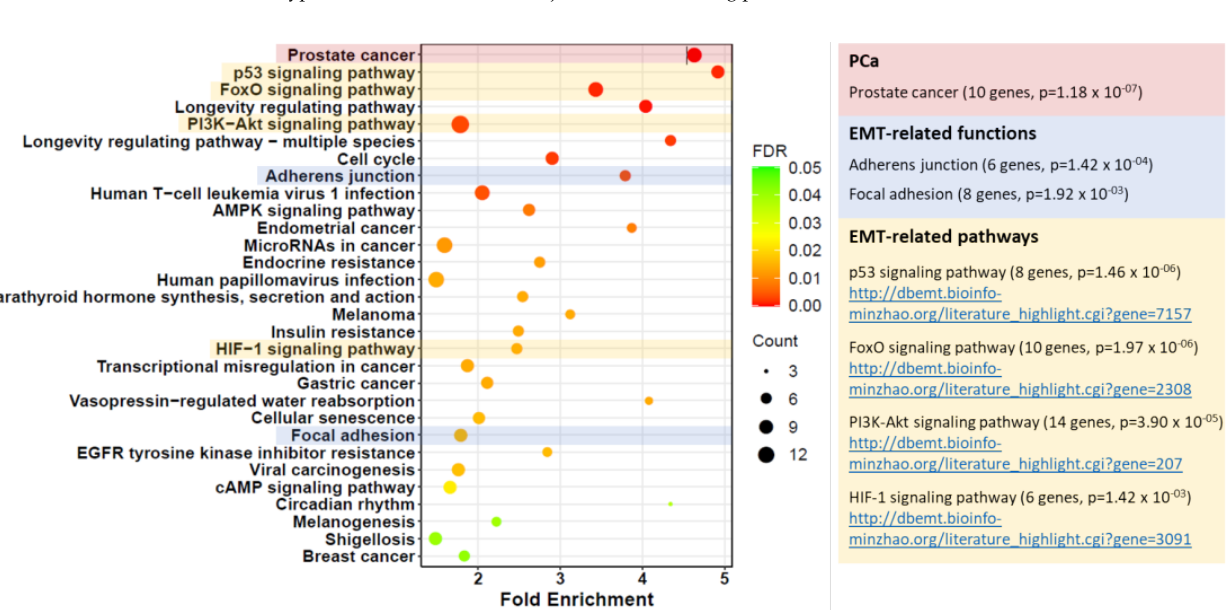
Figure 3 . Bubble plot of KEGG functional enrichment analysis of miR-182-5p targets generated by CancerMIRNome. “Prostate cancer” (PCa) was the top enriched pathway (10 genes, p = 1.18 × 10 − 7 ). The EMT- related functions, “Adherens junction” and “Focal adhesion”, as well as EMT -related sig- nalling pathways “p53”, “FoxO”, “PI3K - Akt” , and “HIF - 1” were also significantly enriched ( p < 0.05, URLs: dbEMT2 literature links).